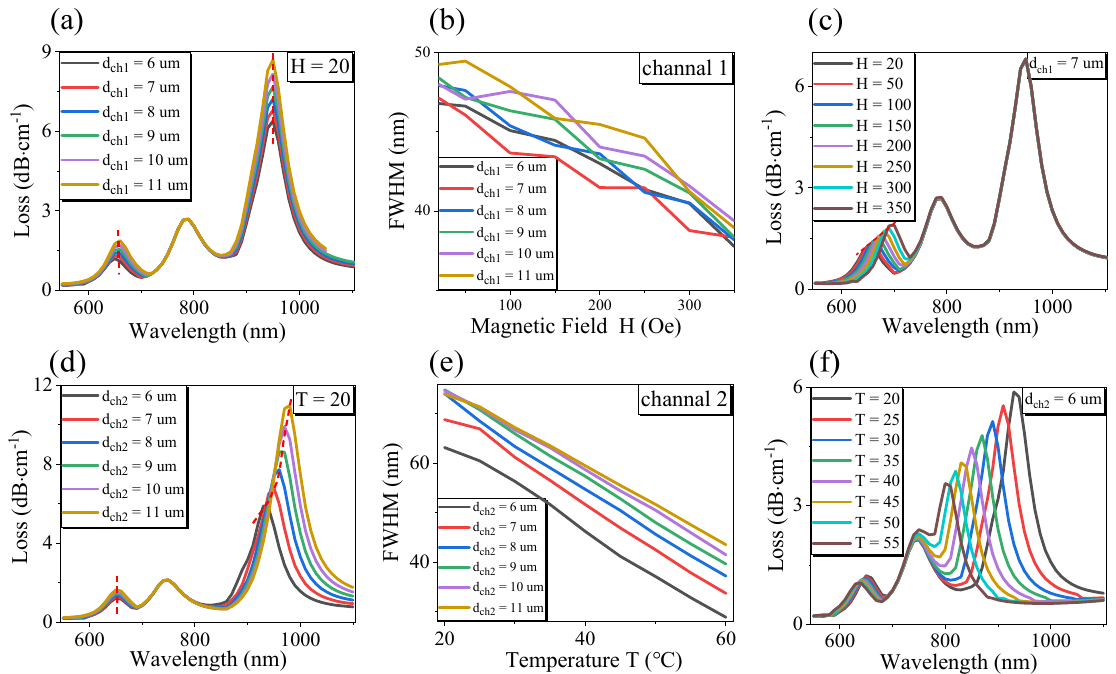
Figure 3. Structure optimization of plasmonic optical fiber sensor under the same refractive index of liquid to be measured: ( a ) The variation of transmission loss of channel 1 with wavelength; ( b ) The variation of FWHM with H under the same T and different channel 1 diameter; ( c ) The variation of transmission loss with wavelength at the same T and different H in d ch1 = 7 µm; ( e ) The variation of FWHM with T under the same H and different channel 2 diameters; ( f ) The variation of transmission loss with wavelength at the same H and different T in d ch2 = 6 µm.